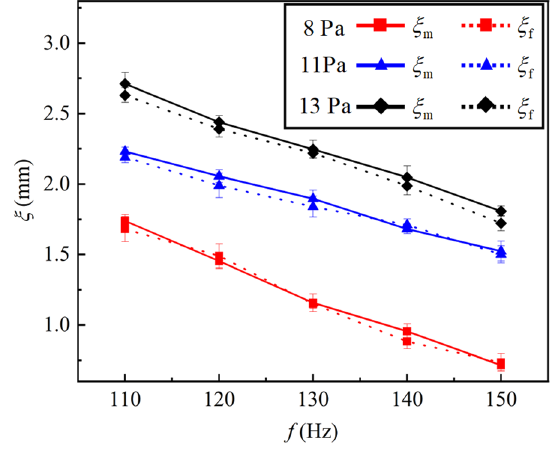
ξ and ξ under the same sound pressure, and the reduction trend with Figure 7. Comparison of Figure 7. Comparison of ξ f and ξ m under the same sound pressure, and the reduction trend with f m increasing frequency f . increasing frequency f